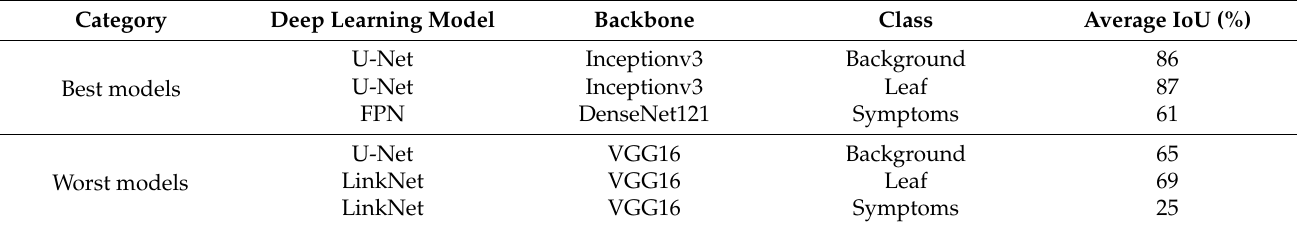
Table 1. Performance summary of the best and worst models used for the prediction of class 1 (background area), class 2 (leaf area), and class 3 (leafminer fly symptom) in the validation data during the training processing.